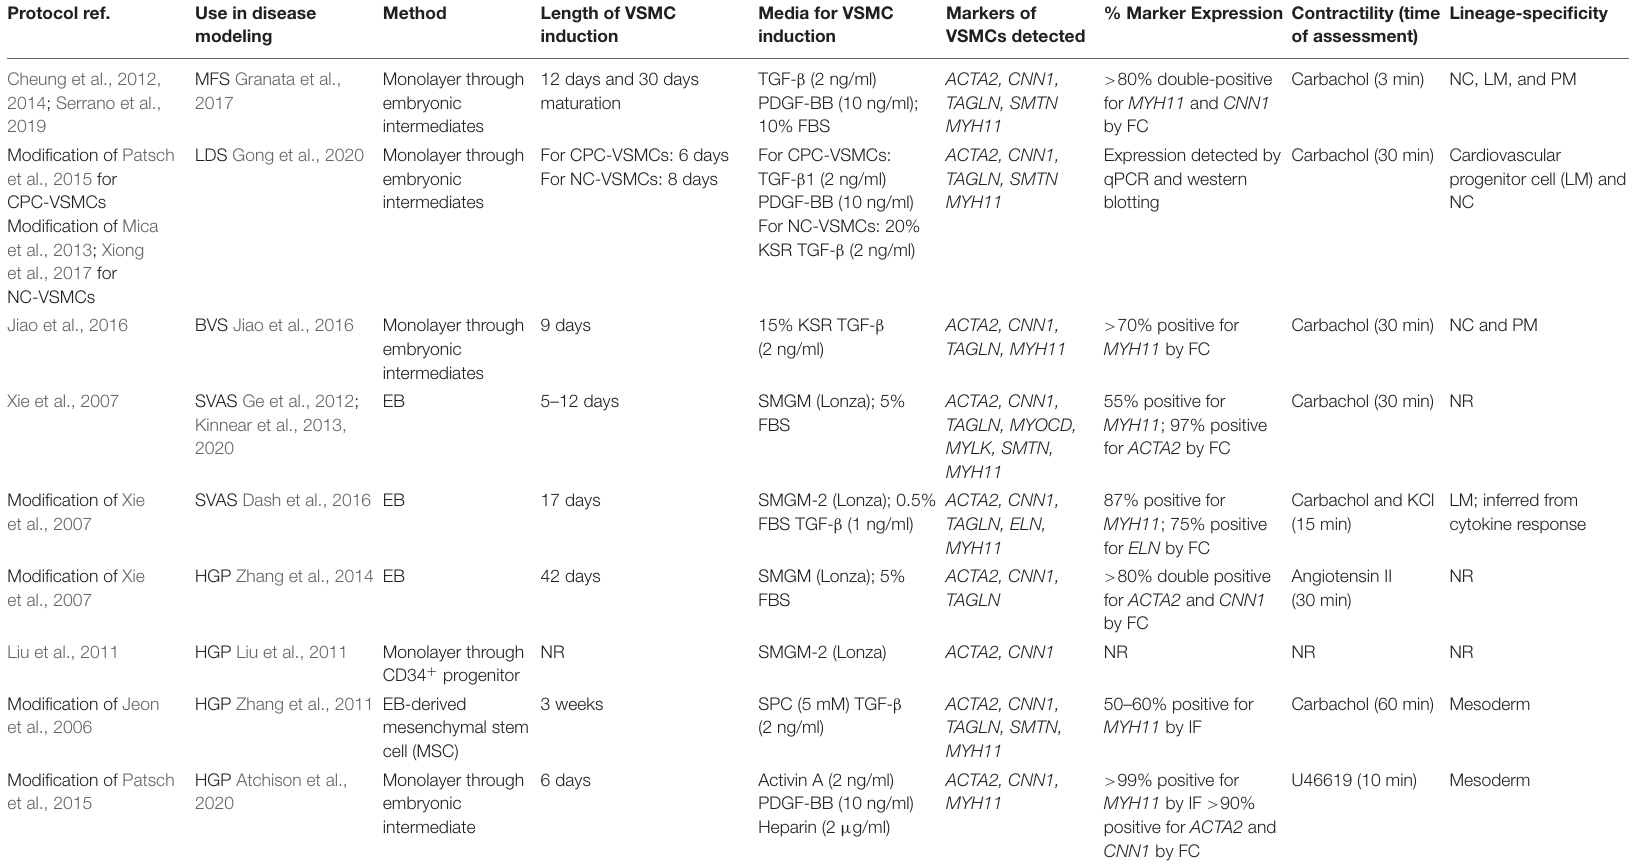
TABLE 2 | Summary of the differentiation protocols and parameters in aortic disease models. Protocol